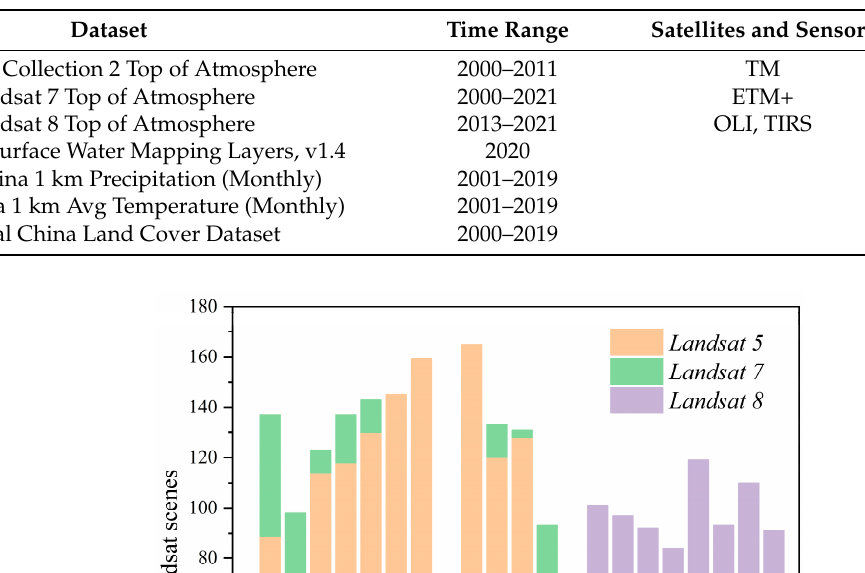
Table 1. Data sources.